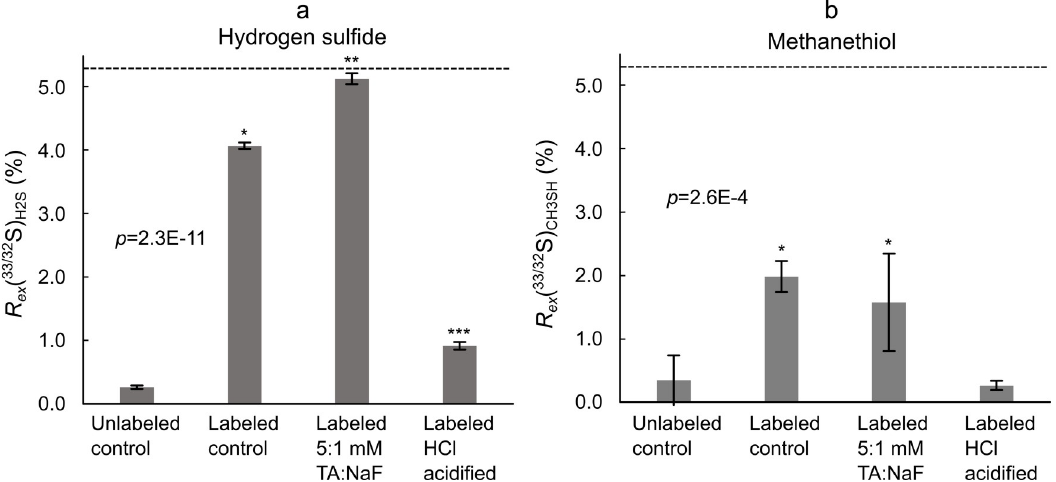
Fig 5. Isotopologue ratios of (a) hydrogen sulfide (H 2 S) and (b) methanethiol (CH 3 SH) from 33 S-sulfate labeled swine manure treated with TA-NaF or acidified with hydrochloric acid (HCl). The dashed line is the R ex ( 33/32 S) SO4 . Data is presented as the mean ± 95% confidence interval. Bars with different number of � are different according to one-way-ANOVA. p-value is for one- way-ANOVA test. The data used is averaged over 2 hours and was measured at day